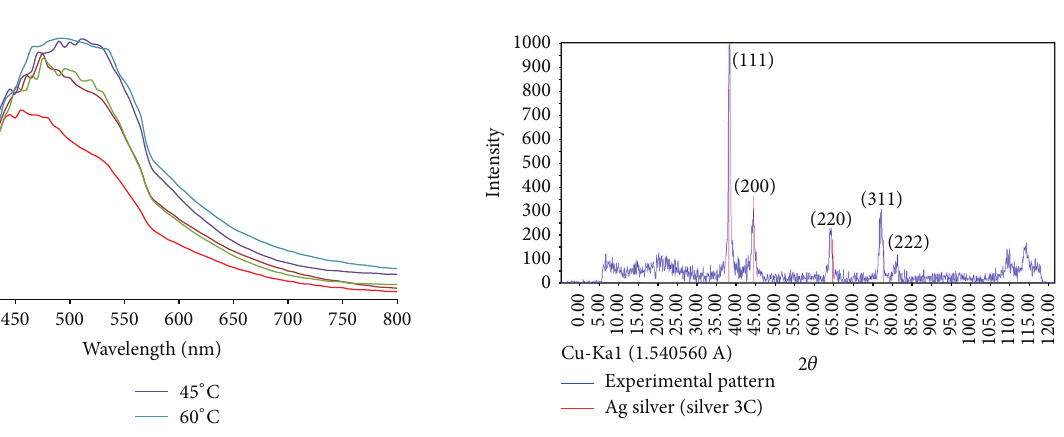
Figure 3: Effect of extract concentration on AgNPs synthesis. Syn- thesis conditions: silver nitrate concentration, 1mM; temperature, 45 ∘ C, extract pH, 9.